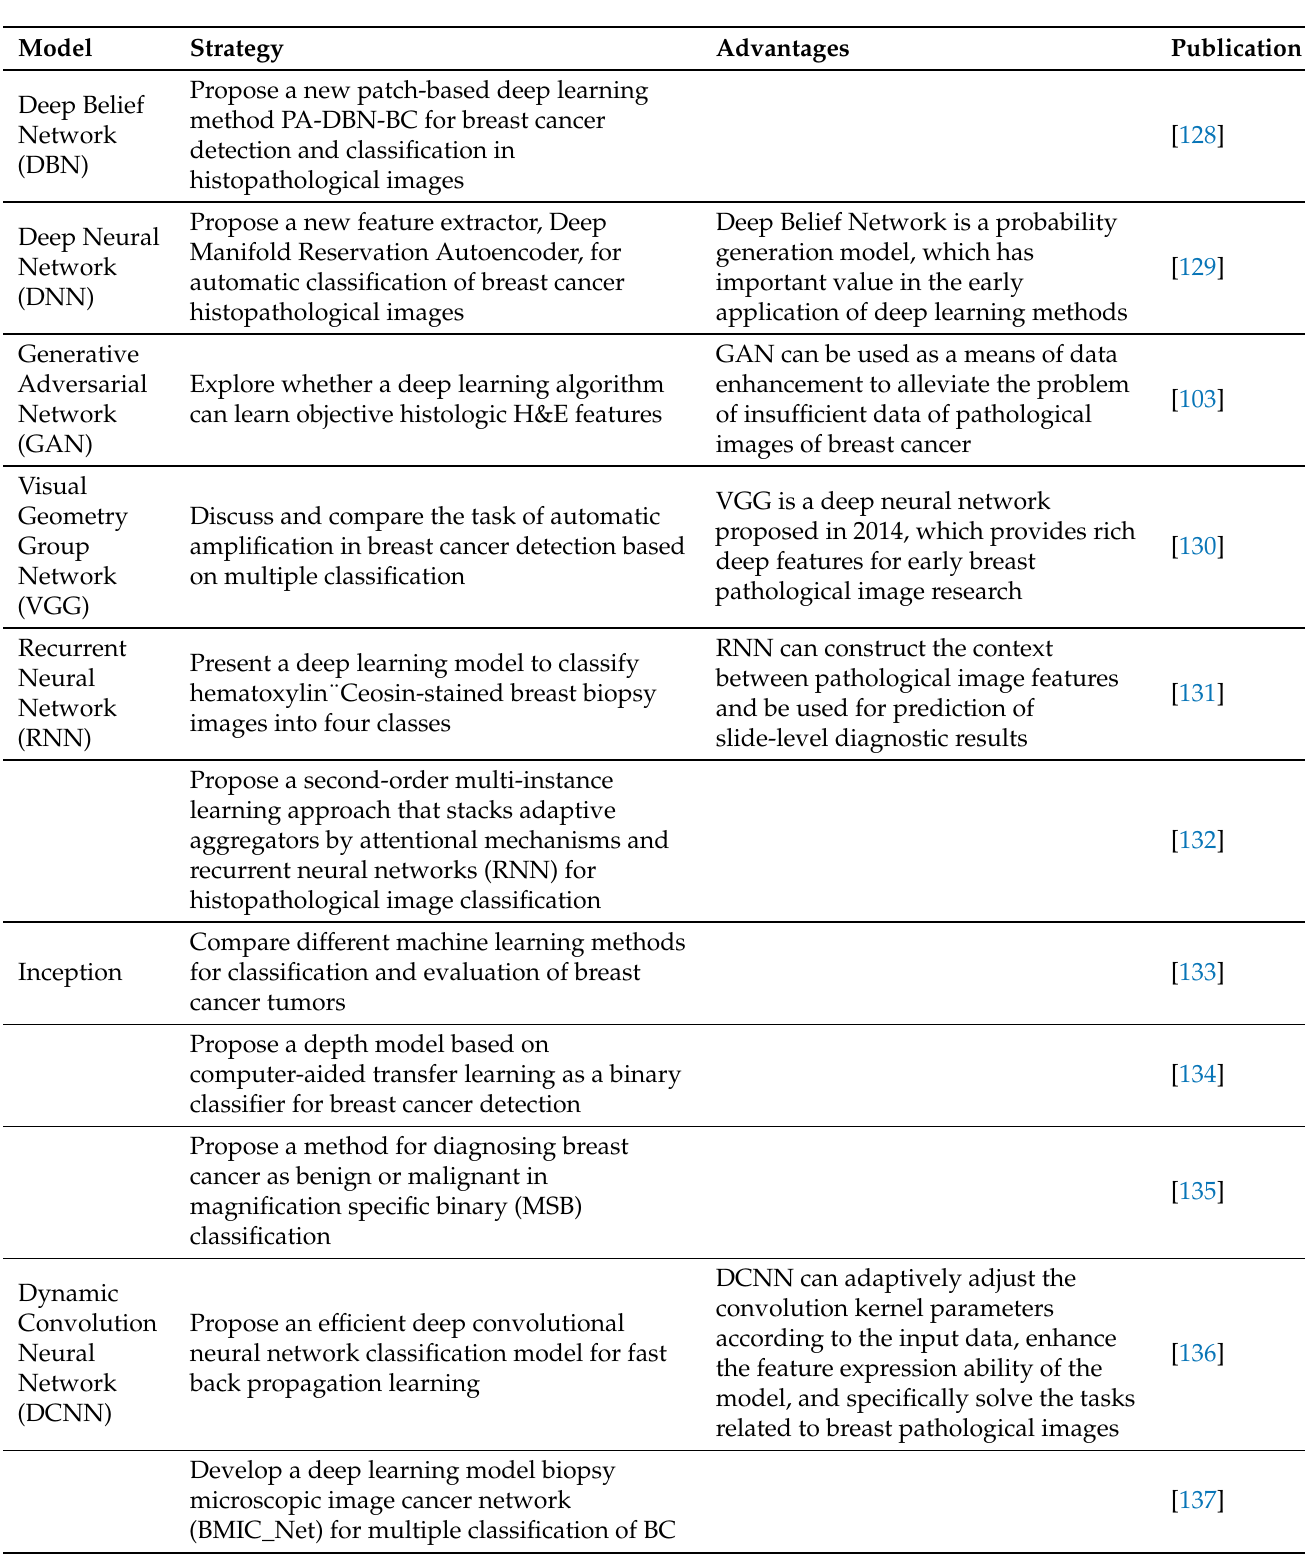
Table 4. Summary of the application of deep learning algorithms in breast cancer histopathology for disease